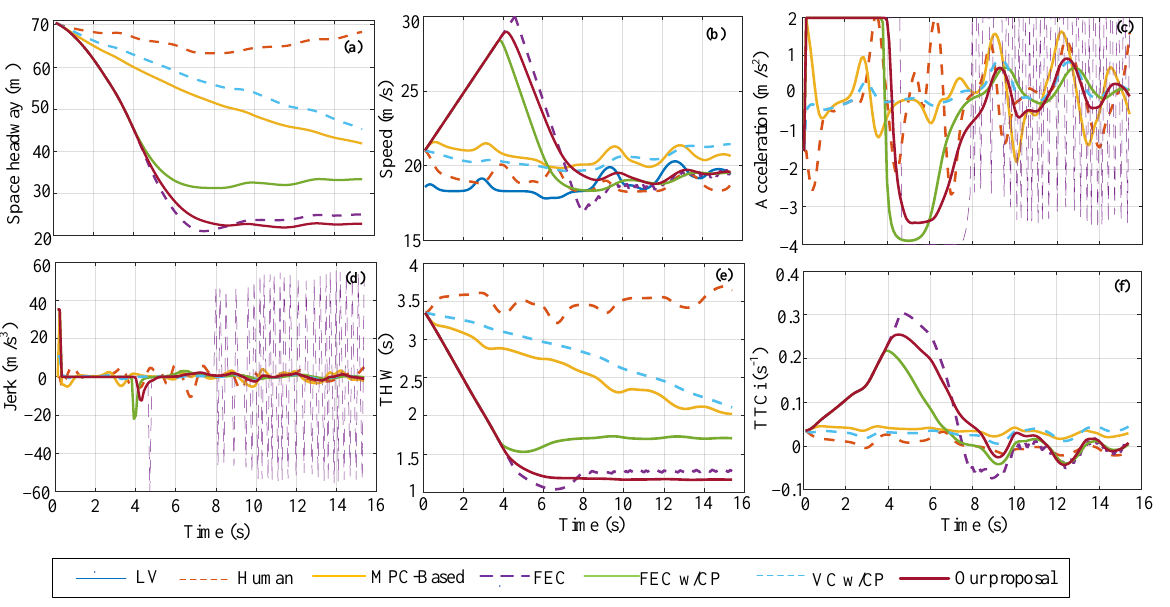
Figure 11. Comparison of decision performance of different strategies in single-scenario test set, where ( a – f ) respectively correspond to space headway, speed, acceleration, jerk, THW, and TTCi.